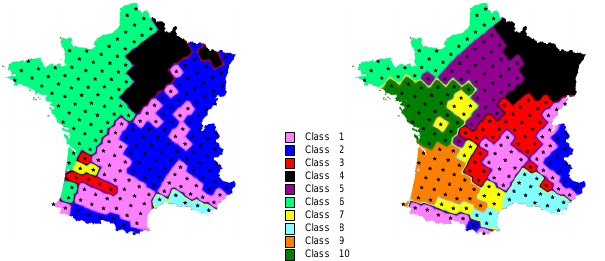
Figure 2. Climatic zones as defined by Multiple factor analysis (MFA) on spatial data: left, classes defined in the distant future applied on the present data, right classes as defined in the distant